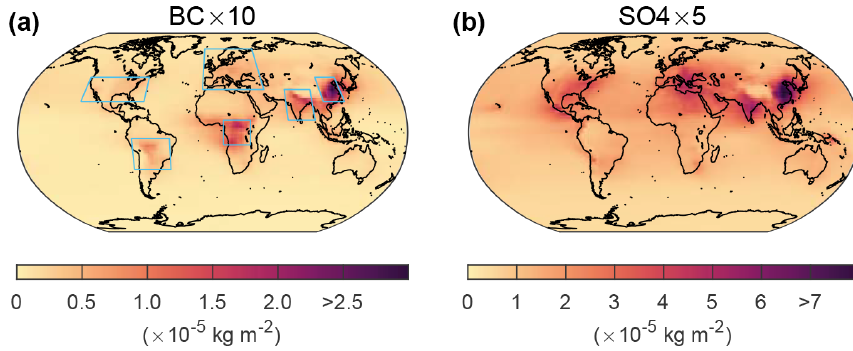
Figure 1. Aerosol loadings for the two aerosol experiments in the NorESM